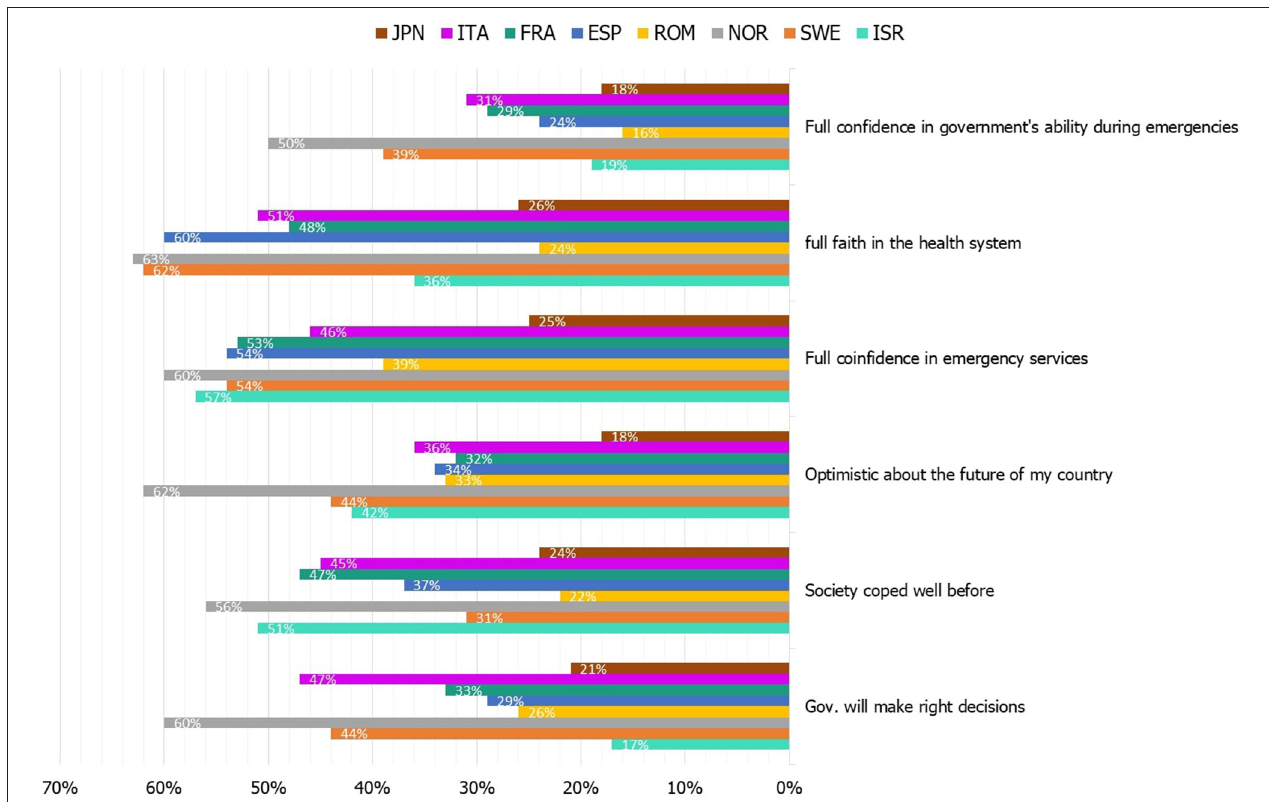
FIGURE 2 | Country comparison of the distribution of agreement (“agree” and “strongly agree”) with items comprising the Societal Resilience Index ( N = 4,013). ISR, Israel; SWE, Sweden; NOR, Norway; ROM, Romania; ESP, Spain; FRA, France; ITA, Italy; JPN, Japan; Gov.,